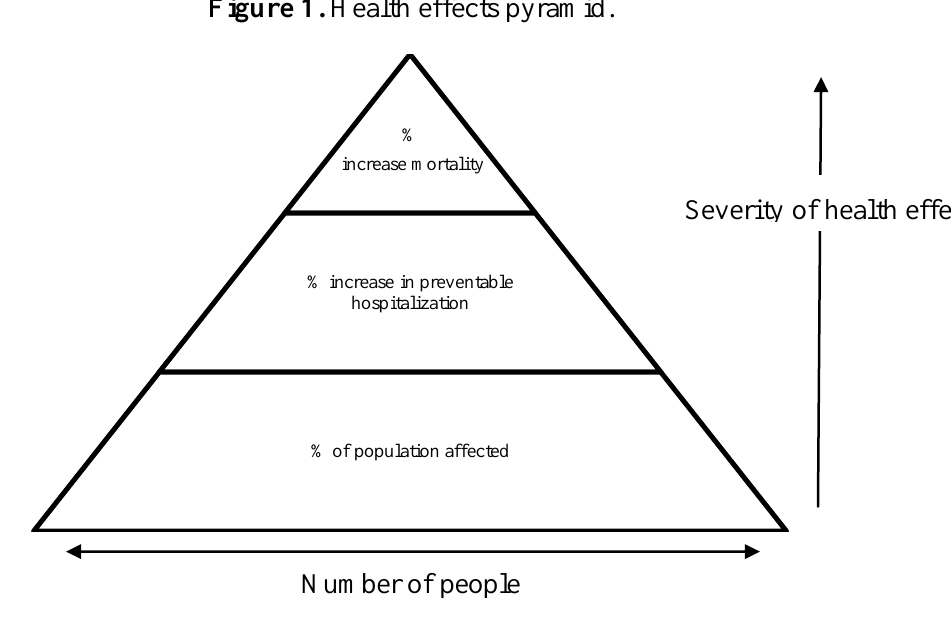
Figure 1. Health effects